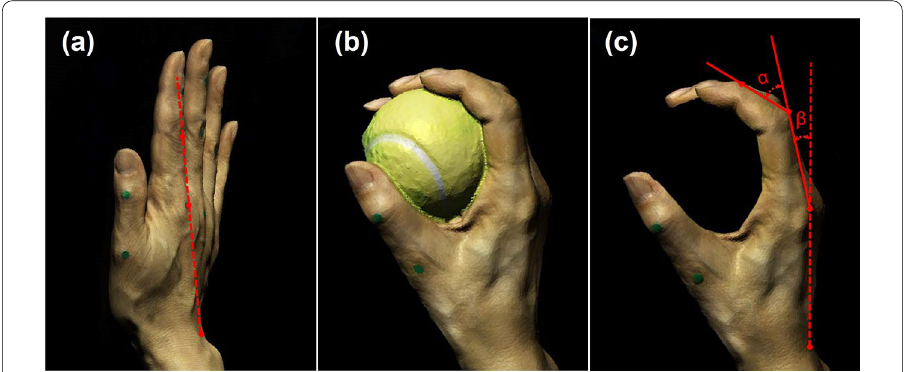
Fig. 2 Angle measurement posture and method using a 3D scanner. a Relaxed posture, b gripping a ball, and c grip posture for angle measurement (α: the external bending angle of the second joint connected to the first joint, and β: the external bending angle of the first joint)